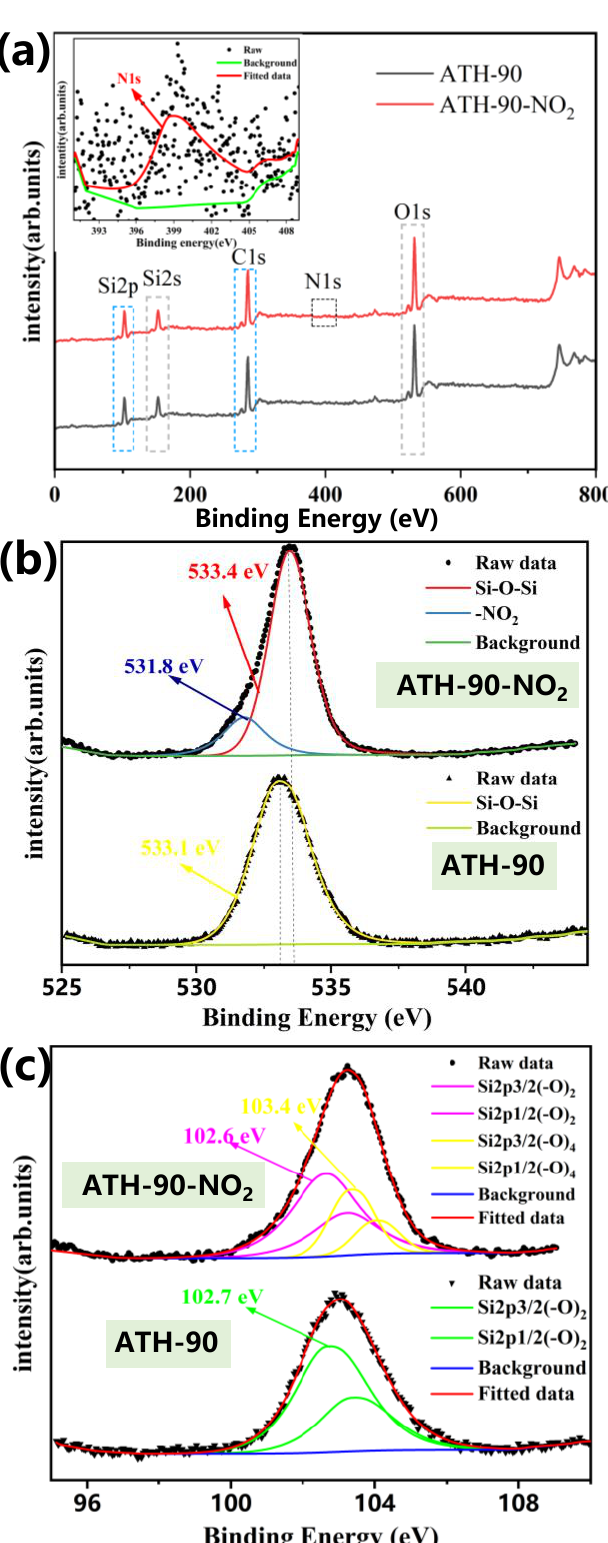
Figure 8. XPS analysis of survey ( a ), O 1s ( b ) and Si 2p ( c ) for ATH-90 SiR before and after NO 2 aging.